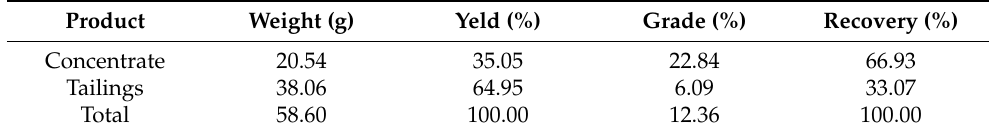
Table 6. Validation test beneficiation index table.